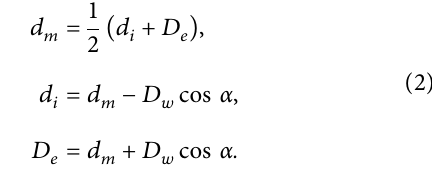
Table 2: Structure parameters of 6206 bearing. Parameters